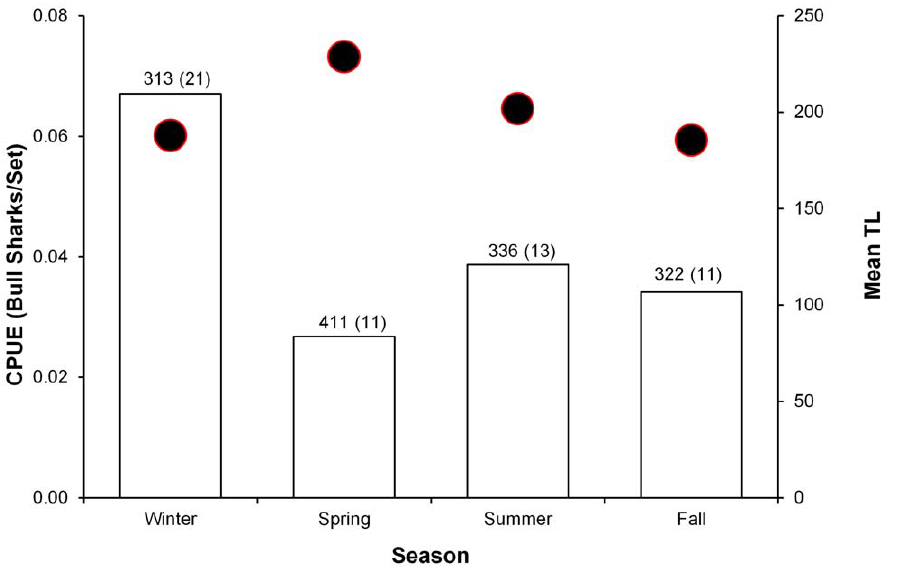
Figure 1. Bull shark catch rates and average size in the catch by season. Data are based on 55 bull sharks captured between October 2009 and May 2012 in the Florida Keys and Florida Bay. Catch per unit effort (CPUE) of drumlines (for all years combined, averaged by season) was used to determine if there were monthly changes in occurrence and size (TL). CPUE was expressed as the number of bull sharks caught per set (bars) and average size of bull sharks caught per set (black dots) within each season (Winter: Dec, Jan, Feb; Spring; Mar, Apr, May; Summer; Jun, Jul, Aug; Fall: Sep, Oct, Nov). Numbers above bars indicate total drumline sets deployed per season (effort) with total bull shark catch per season indicated in parenthesis.